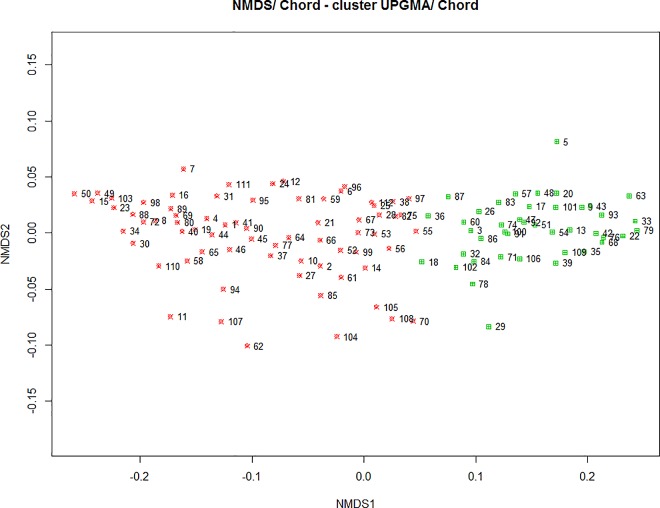
UPGMA clustering of a matrix of chord distance among sites in a NMDS ordination plot for physicochemical data (CCC = 0.72).Sites: Mogadouro (1–10); Mirandela (11–20); Chaves (21–30); Castelo-Branco (31–40); Fafe (41–50); Lousã (51–60); Santarém (61–70); Odemira (71–80); Monchique (81–90); Montemor-o-Novo (91–100) and Amieira (101–112).